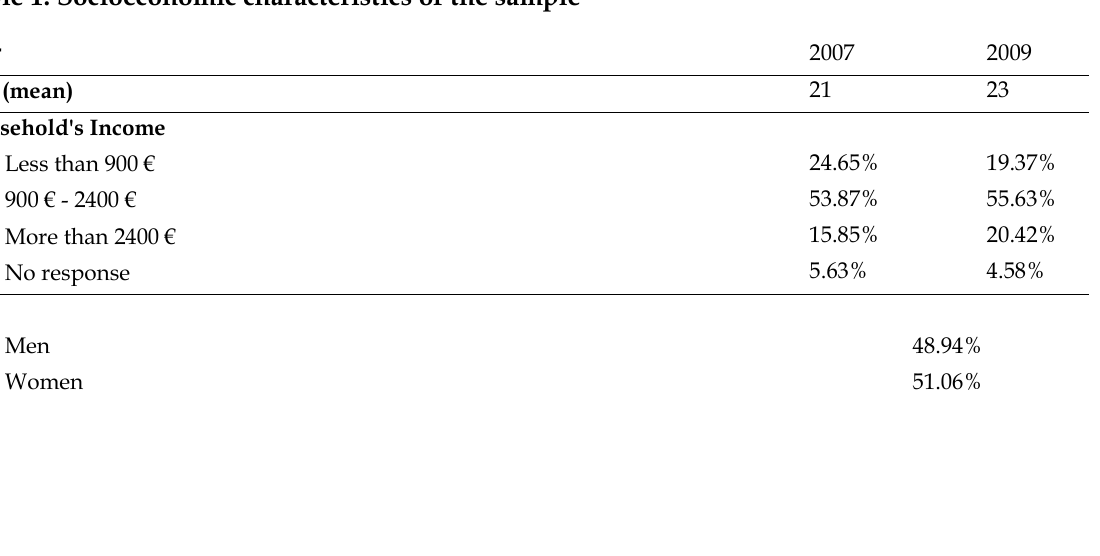
Table 1. Socioeconomic characteristics of the